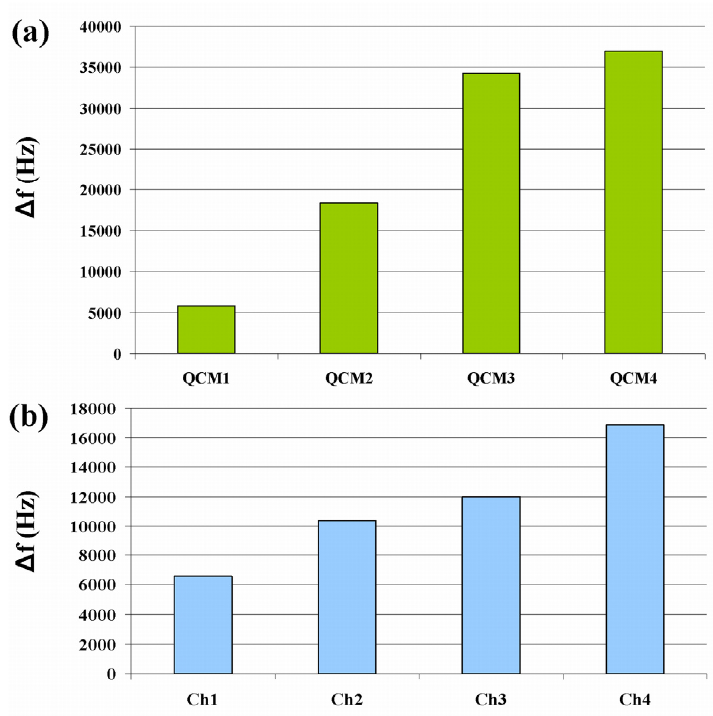
Figure 6. Frequency shift ( Δ f=f-f ) caused by the CIM deposition onto single 0 QCM sensors (a) and MQCM channels (b). f is the resonant frequency after the is the fundamental resonant deposition and f 0